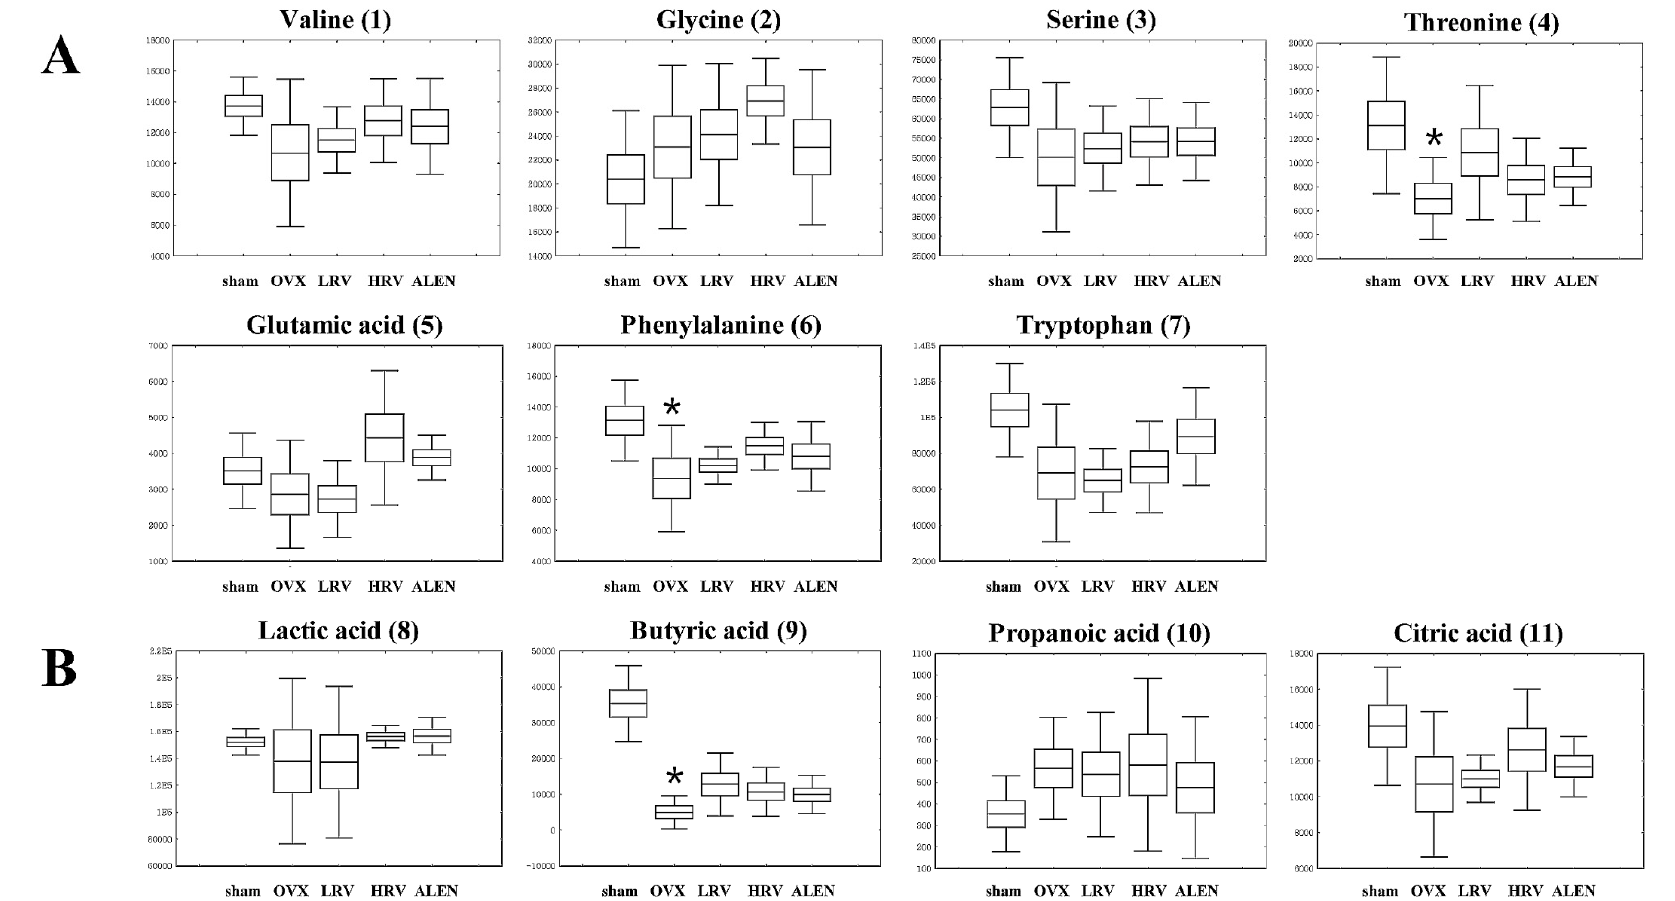
Figure 4. Cont. Figure 4.